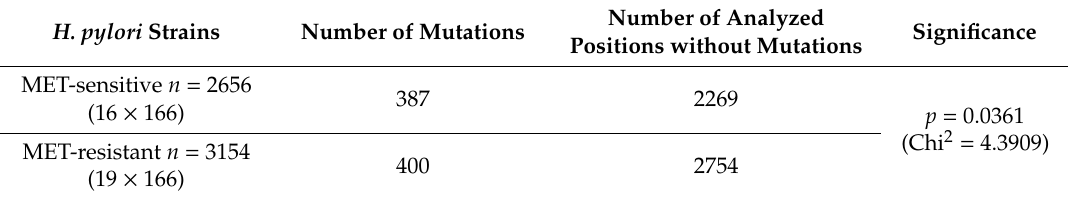
Table 3. Frequency of changes in rdxA gene sequences obtained from 16 metronidazole (MET)-sensitives and 19 MET-resistant H. pylori strains.